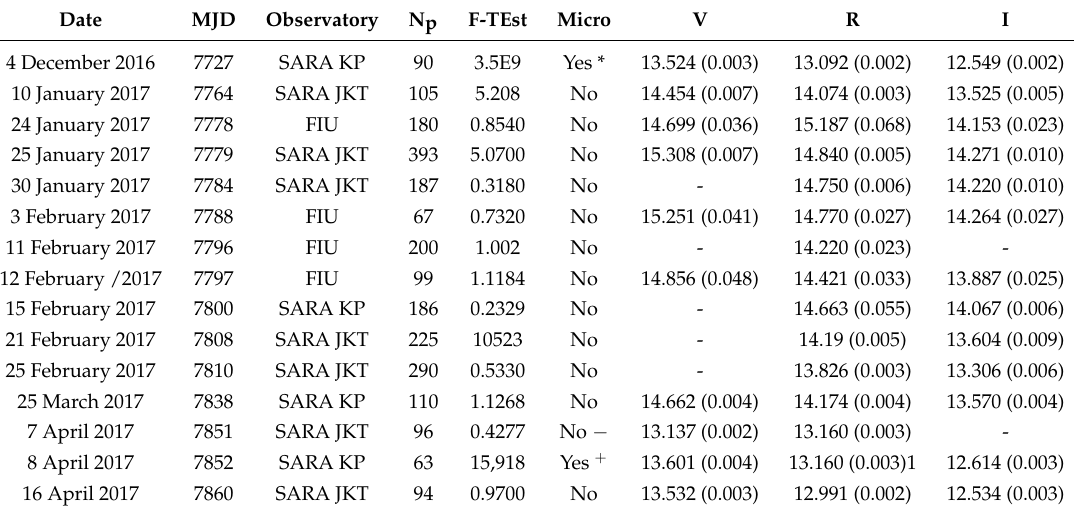
Table 1. The optical observations of S5 0716+71 from 4 December 2016 to 16 April